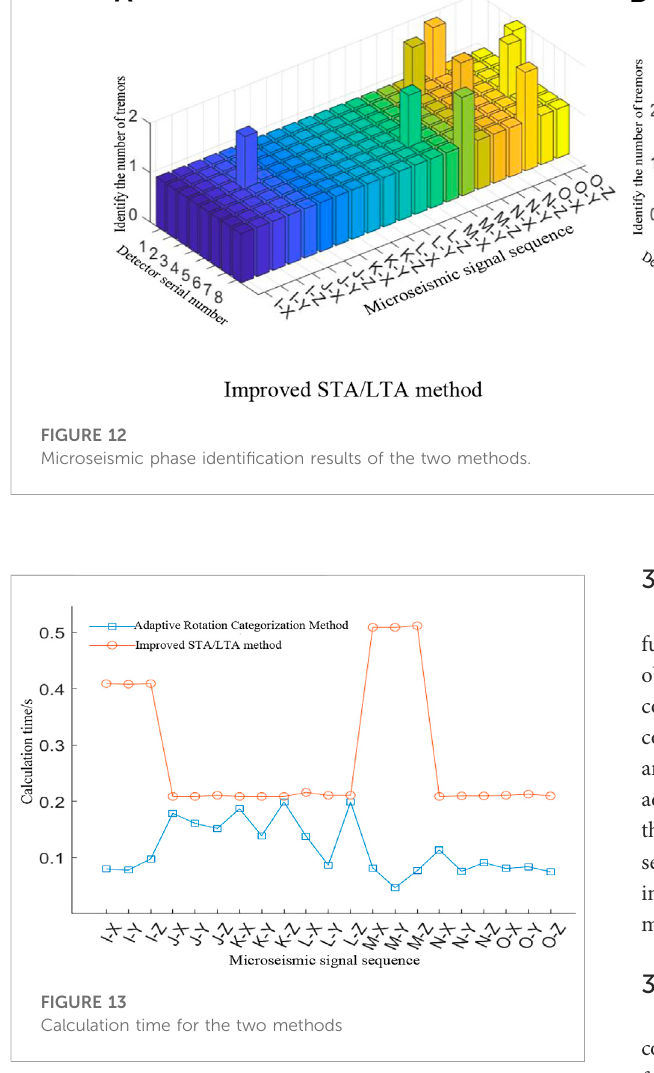
algorithm, variable step accelerated search method, simulated annealing algorithm, and genetic algorithm.